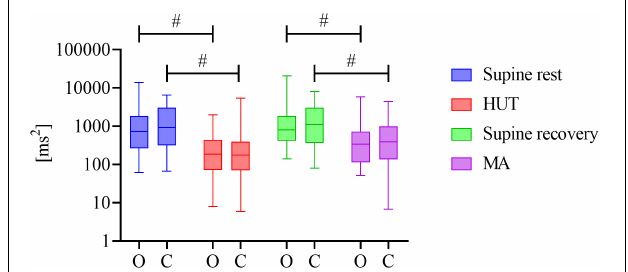
FIGURE 1 | Distribution of HRV spectral power values in the HF band ( y -axis with a logarithmic scale) over four phases (supine rest, HUT, supine recovery, and MA) for the groups of obese (O) and healthy (C) adolescents and young adults. The distributions are shown as box plots. # represents a statistically significant difference between preceding rest phase and physiological stress (orthostasis or mental arithmetic